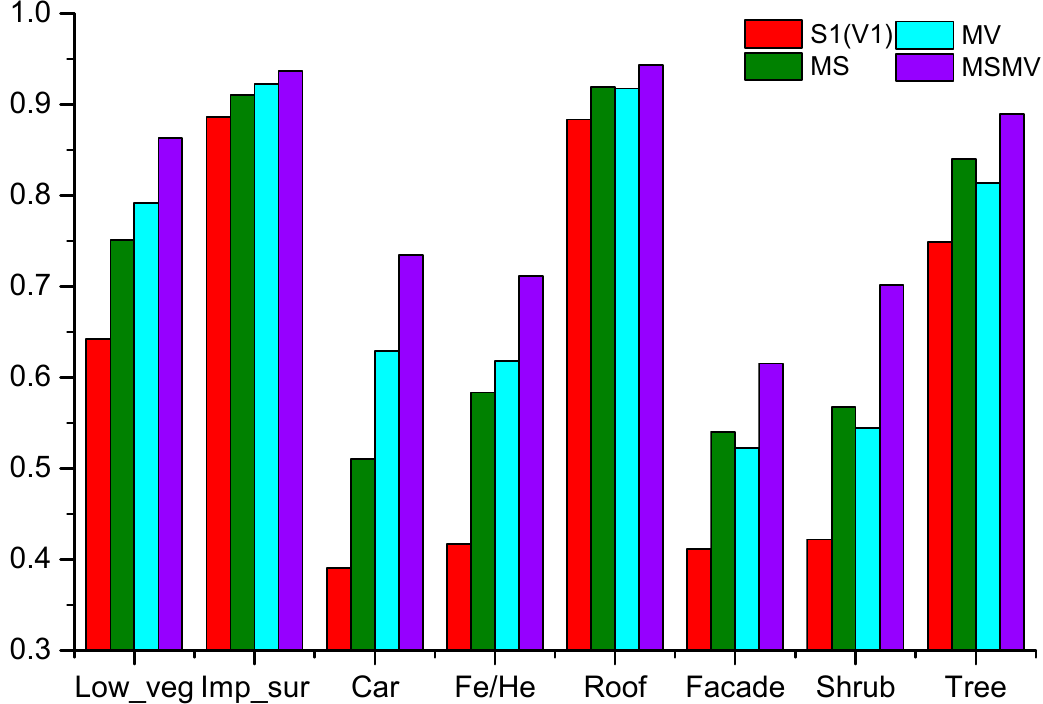
Figure 10. F1 score of each class on ISPRS benchmark dataset under four different configurations.